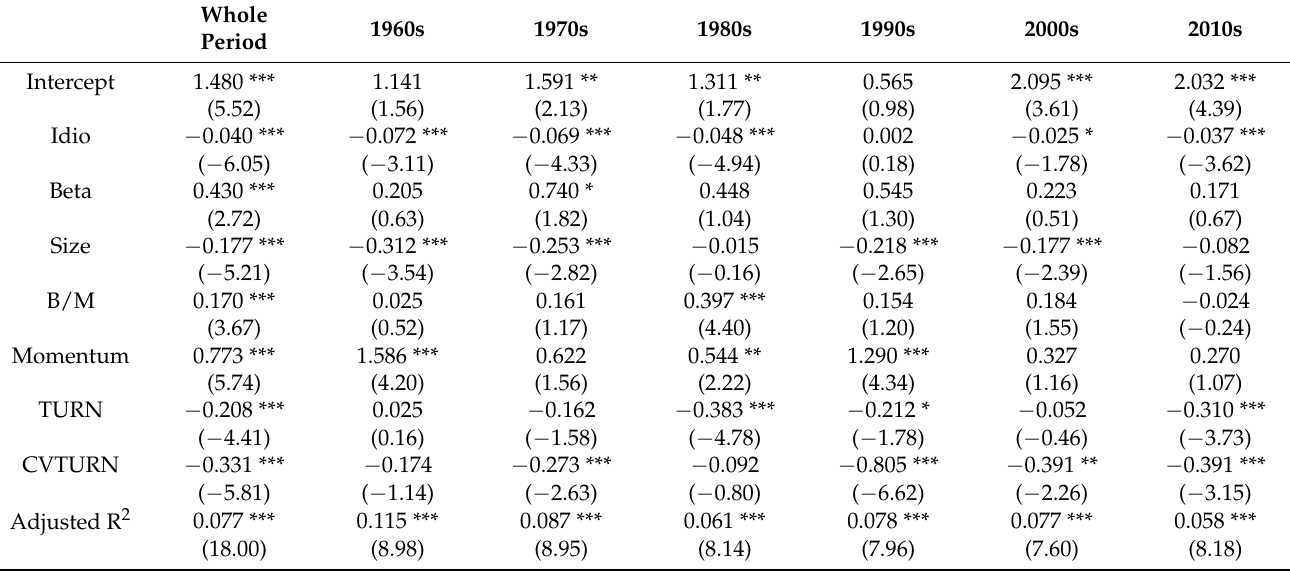
Table A1. This table reports the regression results of robustness tests when idiosyncratic risk is estimated by CAPM model. It reports the results of the firm-level Fama and MacBeth (1973) regressions of monthly stock returns on idiosyncratic risk for the period of July 1963 to December 2019. A stock should have at least 15 daily returns in a month to be included in the risk estimation. Stock-level market beta is estimated from 60-month rollover regressions. ME Size and B/M are size and book-to-market ratio in Fama and French (1992). Momentum is the compound gross return from month (t − 7) to (t − 2). TURN and CVTURN are the average volume turnover and coefficient of variance of TURN calculated over the past 36 months in Chordia et al. (2001). The idiosyncratic risk (Idio) is the standard deviation of regression residuals of daily stock returns in month t − 1. The Newey–West adjusted t-value is reported in parentheses. To avoid the effect of possibly spurious outliers, all explanatory variables below 0.1 (above 99.9) percentile are set equal to 0.1 (99.9) percentile. *, ** and *** denote the statistical significance level at 10%, 5% and 1%,